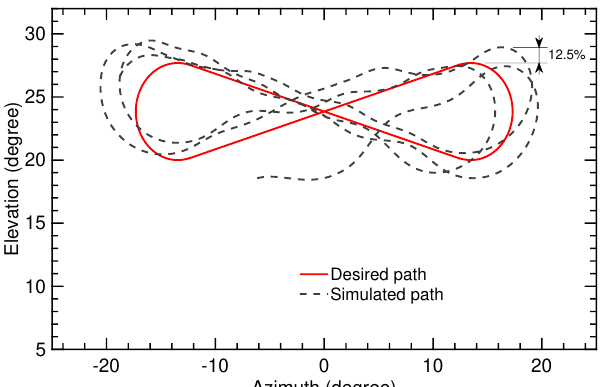
Figure 21. Trajectory computed on the basis of the SI algorithm and adaptive controller for flight time of 70 s.